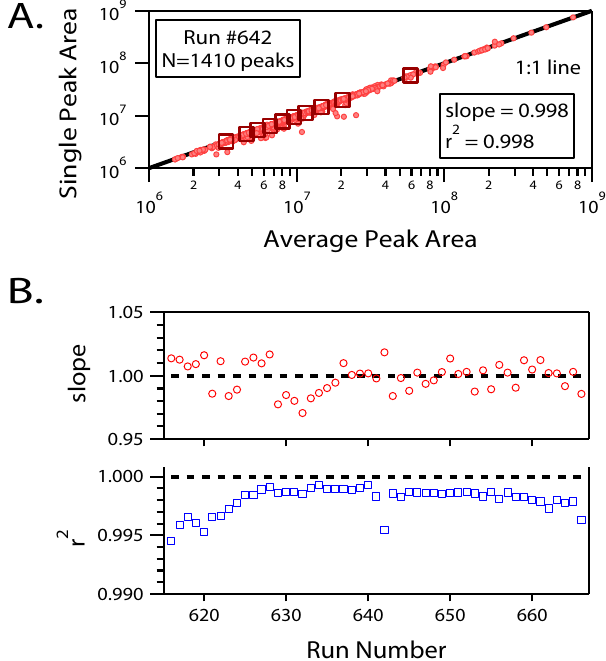
Figure 3. Comparison of reproducibility of injection and derivati- zation of 50 consecutive injections of a methanol extraction of a fil- ter collected in the Sierra Nevada of California. Responses of 1410 peaks in each injection were compared to the average response of each peak. This comparison is shown for (a) the injection in the middle of the series, where pink circles show all peaks compared and red squares show peaks binned by size into 10 equal bins (140 peaks each). (b) The slope (red circles) and correlation coefficient (blue squares) are shown for all comparisons in the series. Perfect correlation (slope = 1, r 2 = 1) is shown as a dashed